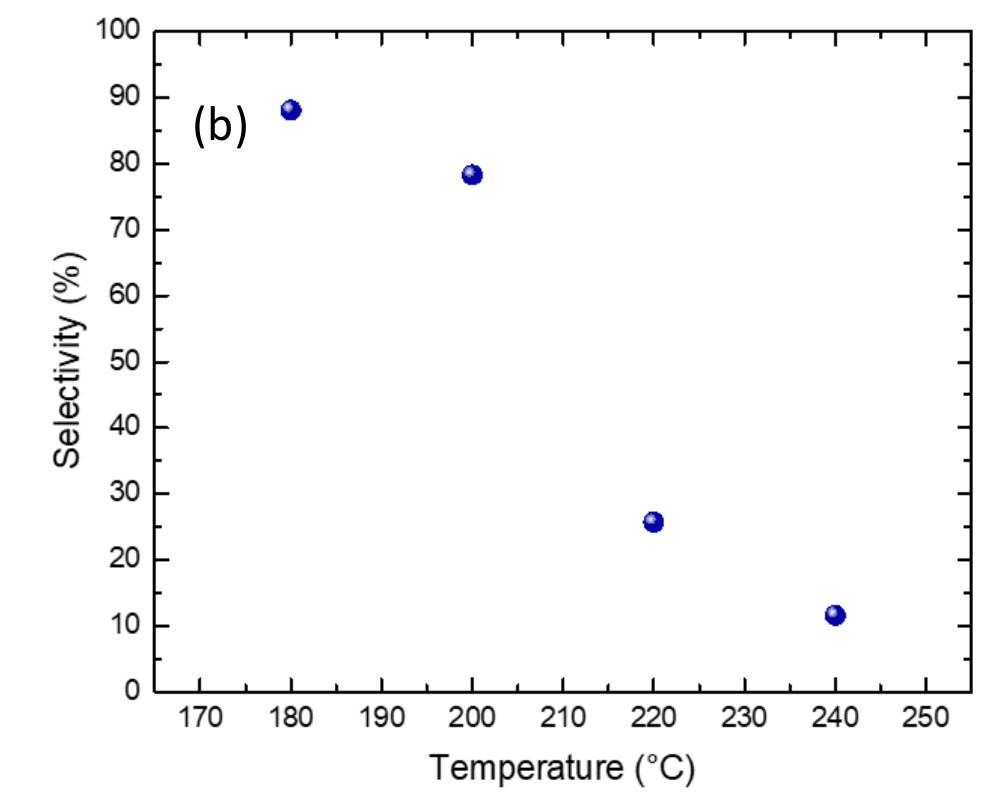
Figure 4. ( a ) Conversion and ( b ) selectivity for CZA-30 ′ at 5 bar, T = 180, 200, 220, and 240 °C.